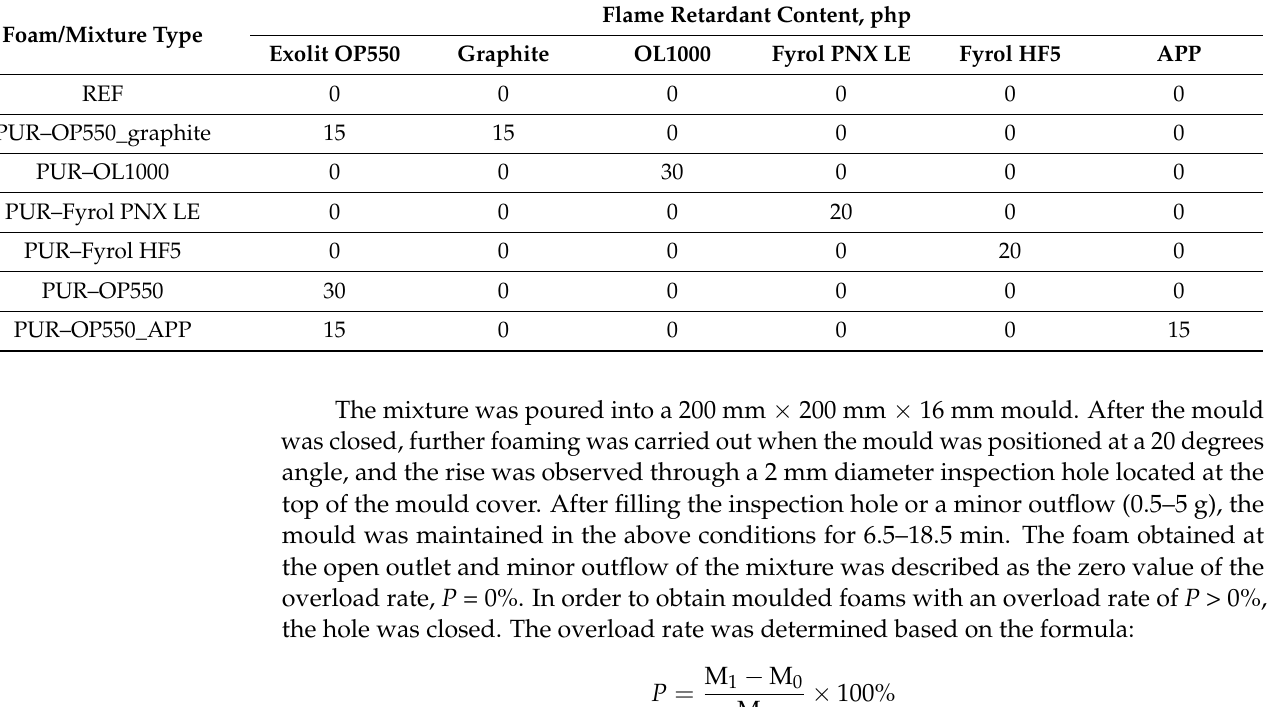
Table 2. Weight ratios of flame-retardants in foam formulations and mixtures for viscosity testing. Flame Retardant Content, Foam/Mixture Type